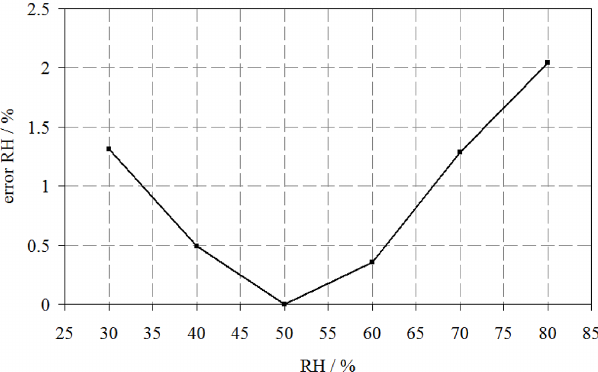
Figure 10. Error of the relative humidity using a one-point calibra- tion at 50%RH and 25 ◦ C. The maximum error of four sensors is ±